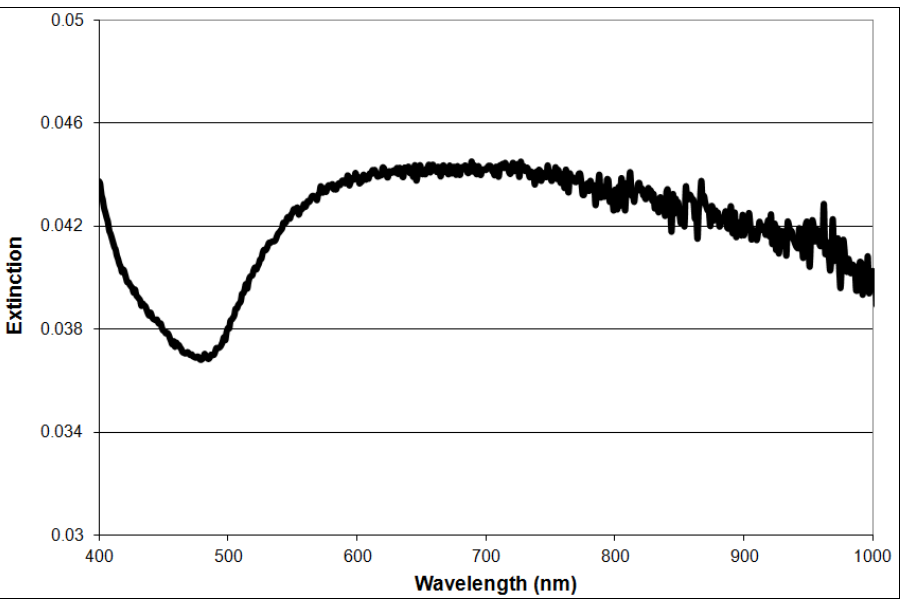
Figure 3. Extinction spectra of 40 nm gold